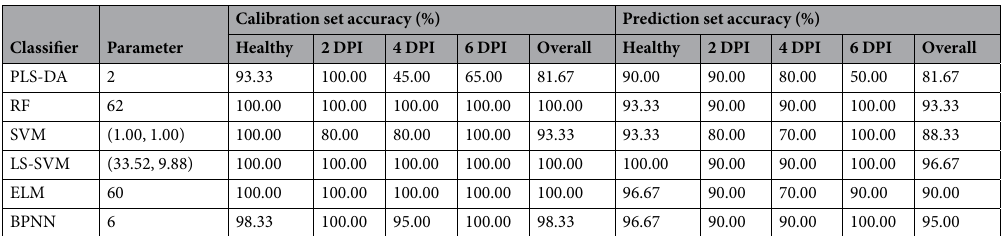
Table 3. Classification results of machine-learning models with data fusion combining optimal wavelengths and texture features. a a Parameters and abbreviations as in Table